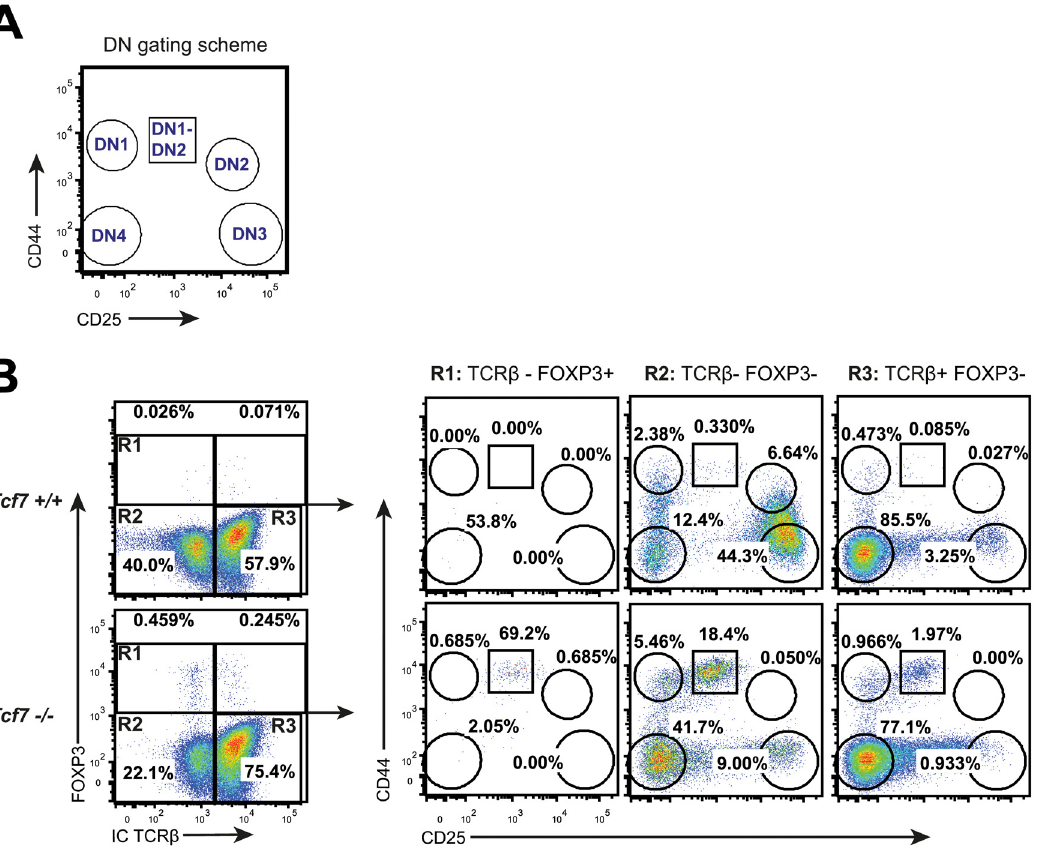
Fig 3. Expression of Foxp3 at thymic DN1-4 stages. (A-B) Flow cytometric analysis of CD4 - CD8 - (DN) thymocytes from Tcf7 +/+ and Tcf7 -/- mice. (A) Gating scheme for the identification of DN1-4 and DN1 to DN2 transition stages based on the expression of CD44 and CD25. (B). Left panels: Representative plots showing Foxp3 and intracellular (IC) TCR β staining in DN thymocytes from Tcf7 +/+ and Tcf7 -/- mice. Right panels: Representative plots showing CD44 and CD25 expression on the indicated DN populations (R1 – R3). Numbers show percentages of cells within the indicated box.